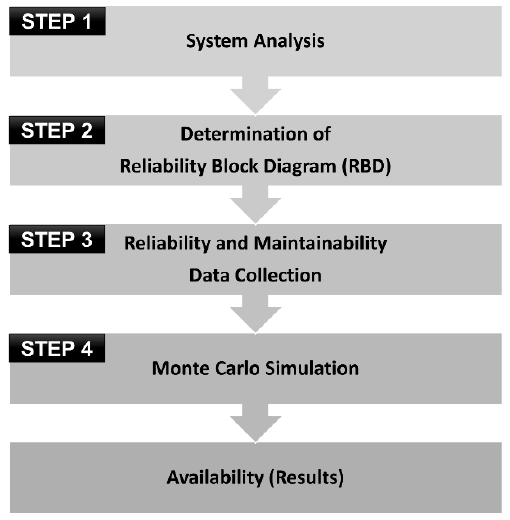
Figure 6. Procedure for availability estimation using Monte Carlo simulation.